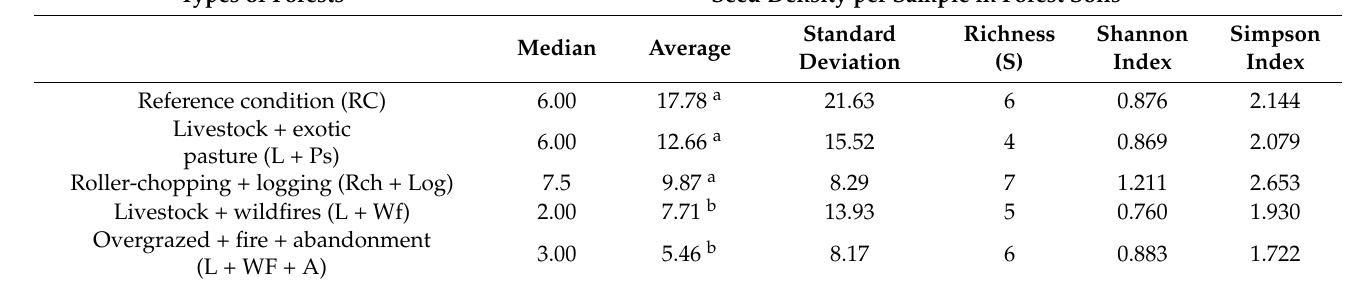
Table 2. Average, median, and standard deviations of seed density per sample, and species diversity in soil seed banks from Chaco-region forests with different land-management types. RC = reference condition forest; L + Ps: grazed forest with tropical pasture sowing; Rch + log = rolled-chopping and logged forest; L + Wf = grazed and burnt forest; L + Wf + A = overgrazed, burnt, and abandoned forest.